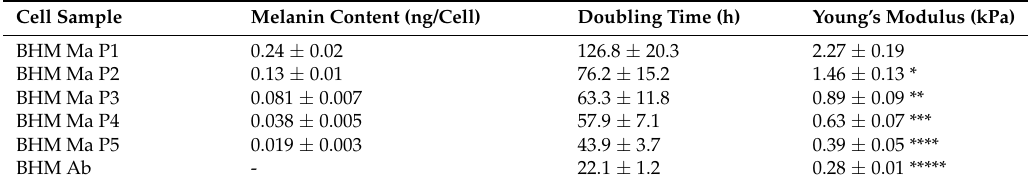
Table 1. Numerical values of the obtained results for BHM cells.